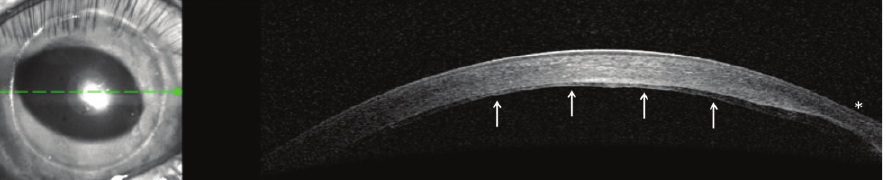
Figure 2: Anterior segment OCT of the right eye showing a stable DSEK graft eight months after placement (white arrows). Extreme peripheral corneal ectasia is evident (white star).